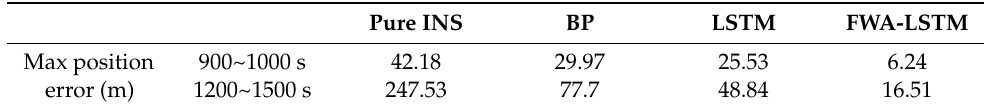
Table 1. Max position error during GNSS unavailable